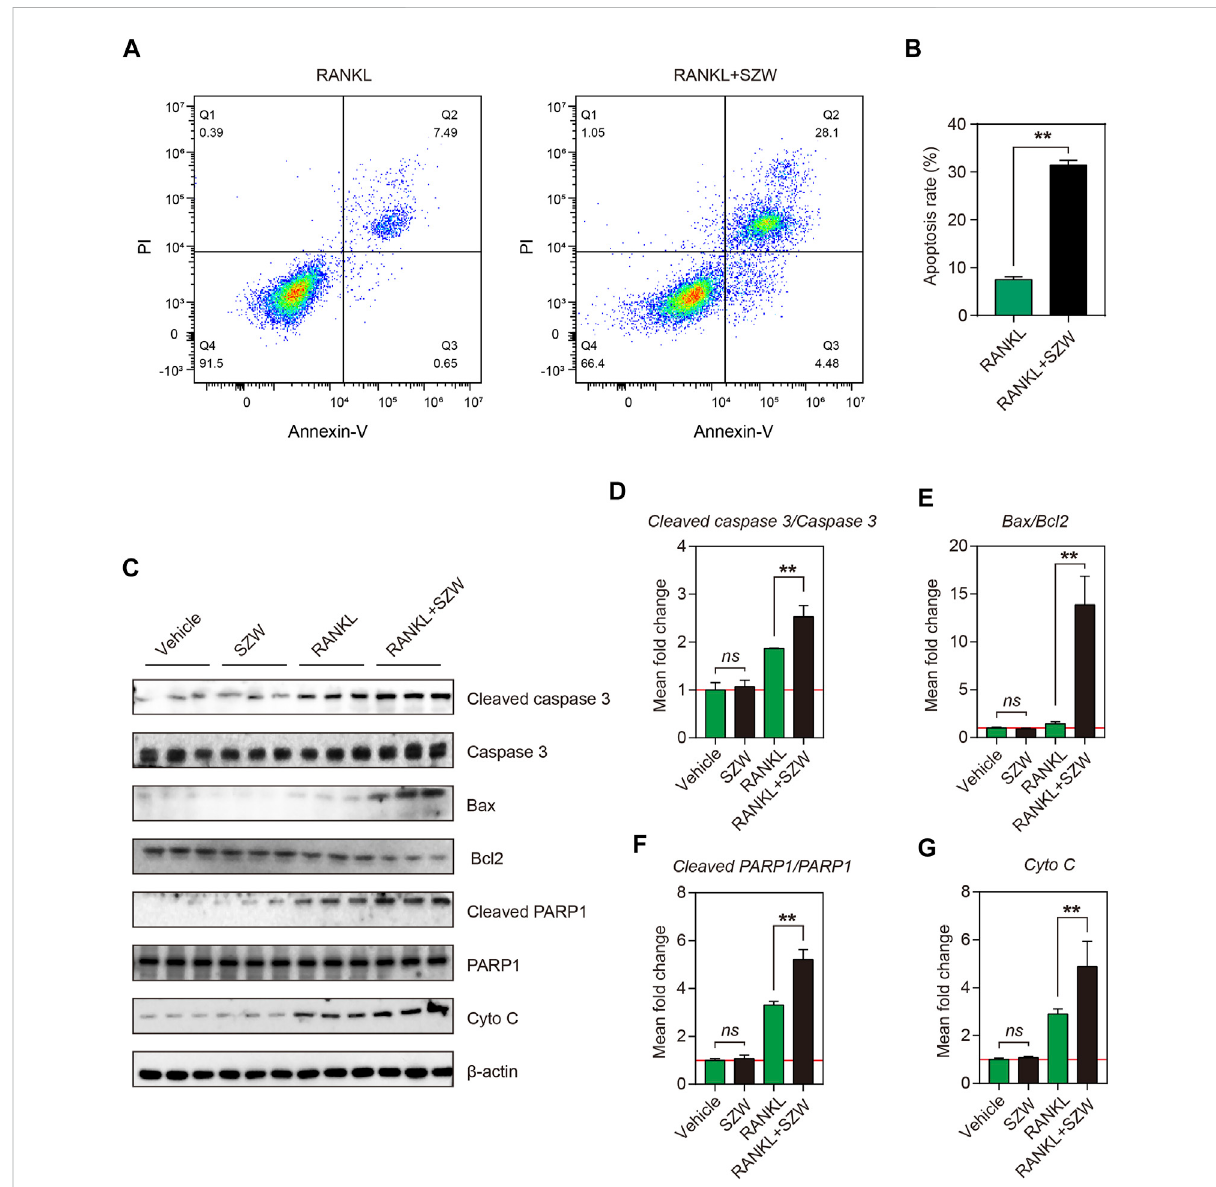
FIGURE 4 SZW promoted apoptosis of mature osteoclasts. RAW264.7 cells were treated with vehicle (H 2 O) or SZW in the presence or absence of RANKL (A) Representative fl ow cytometry pictures of osteoclast apoptosis (B) Quantitative statistics of apoptosis rate (C) Representative western blotting imagesshowingCleavedcaspase3,Caspase3,Bax,Bcl2,CleavedPARP1,PARP1,andCytochromecexpressionlevelinRAW264.7 (D) Themeanfold change of Cleaved caspase 3/Caspase three ratio (E) The mean fold change of Bax/Bcl2 ratio (F) The mean fold change of Cleaved PARP1/ PARP1 ratio (G) The mean fold change of Cytochrome c level. Data are expressed as the mean ± SEM (n = 3). p p < 0.05, pp p <